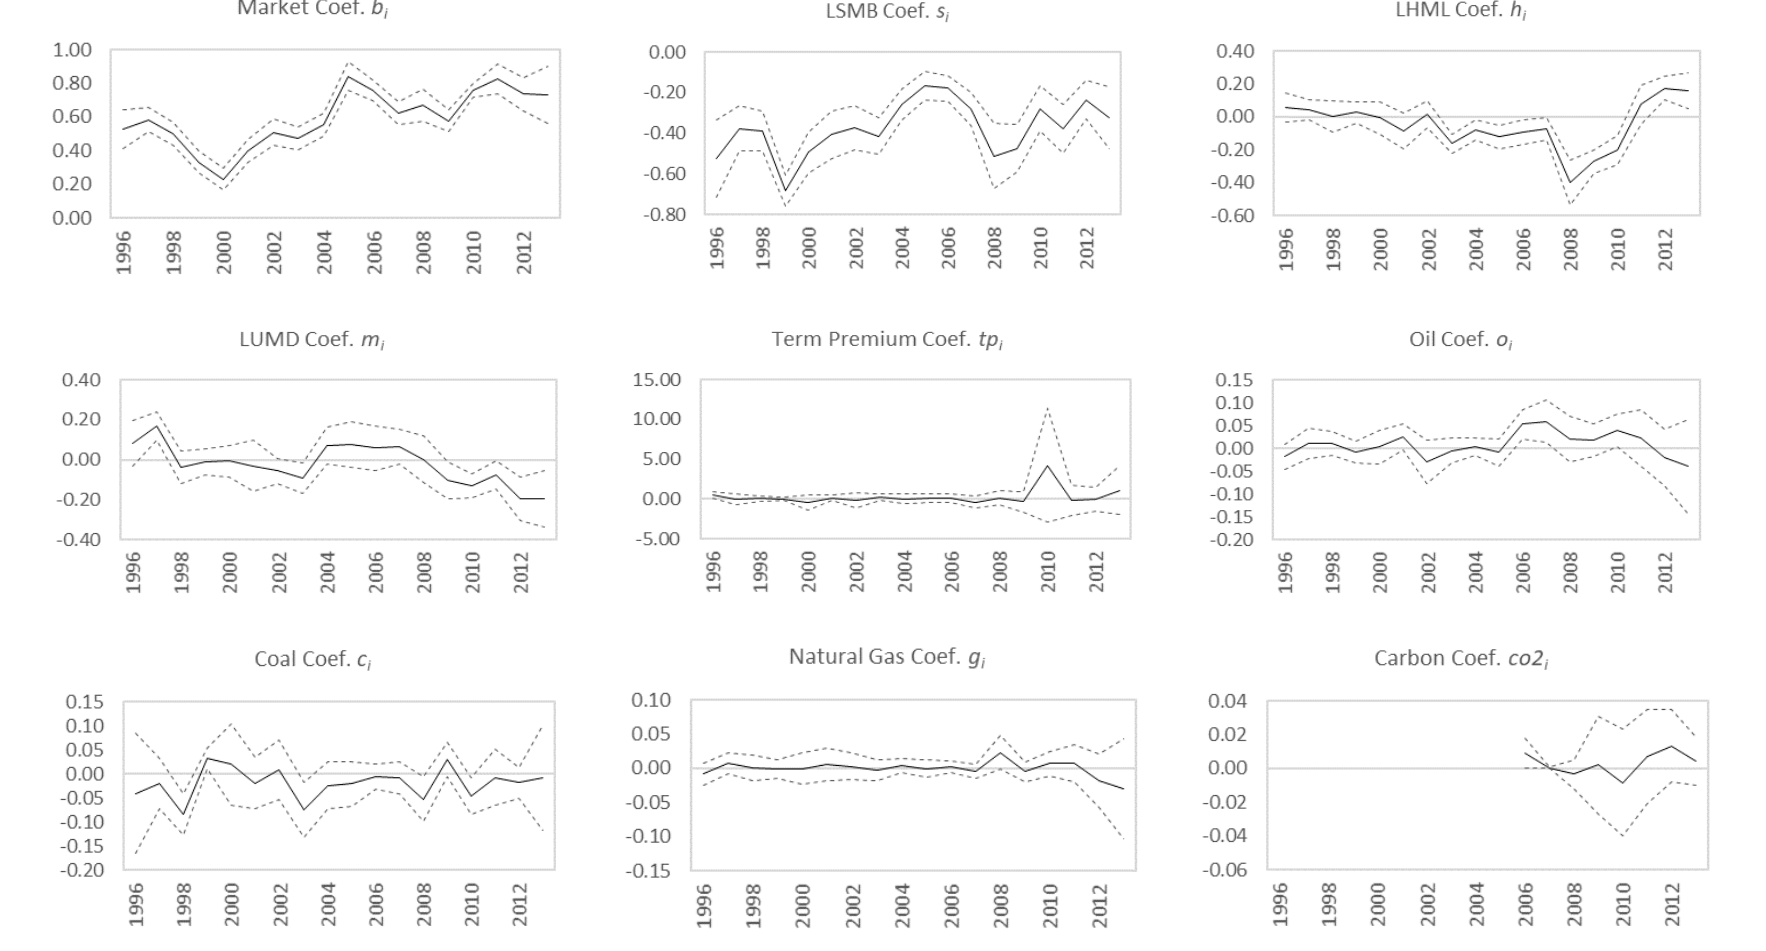
Figure 3. Local AFFM estimated coefficients and 95% confidence intervals over time. This figure illustrates the estimated coefficients for the nine risk factors through time, using the annual local AFFM results from Table 3. The solid line represents the estimated coefficient, while the dotted line represents the 95% confidence interval. When the 95% confidence interval overlaps zero, the test of significance fails at the 5% level.